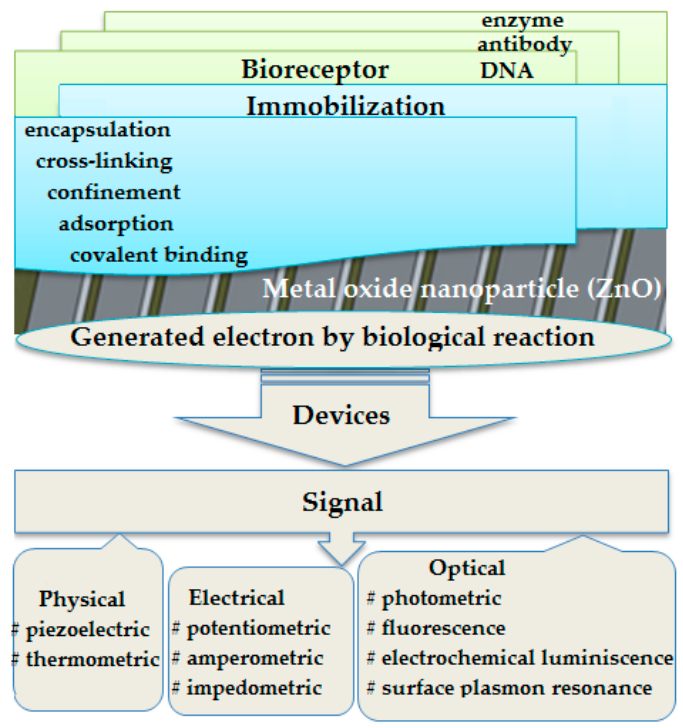
Figure 1. Working principles of a biosensing materials-based enzyme.